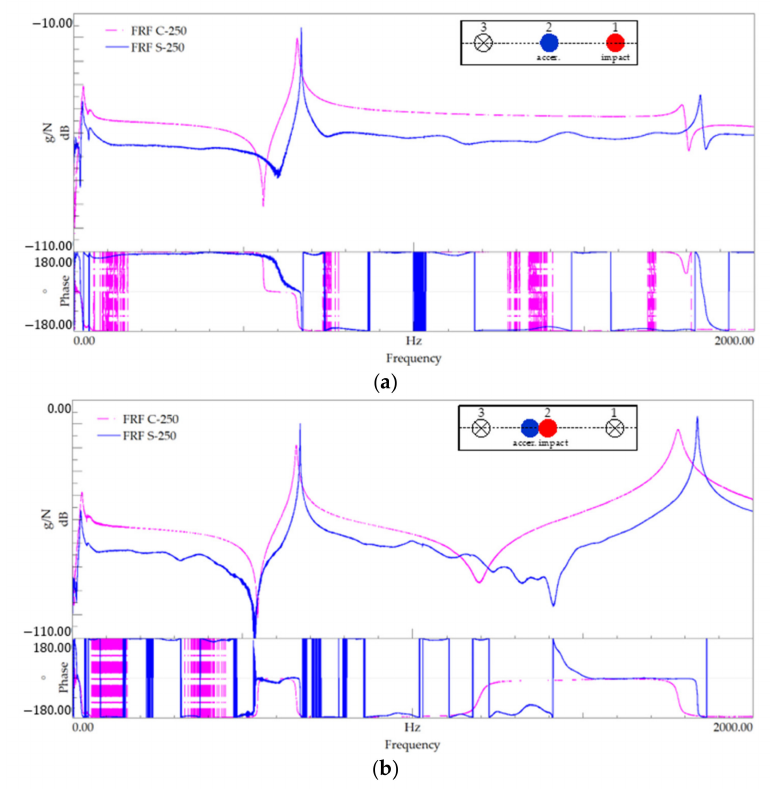
Figure 14. Modal identification for the 250 mm-length—FRF plot for ( a ) series 1 and ( b ) series